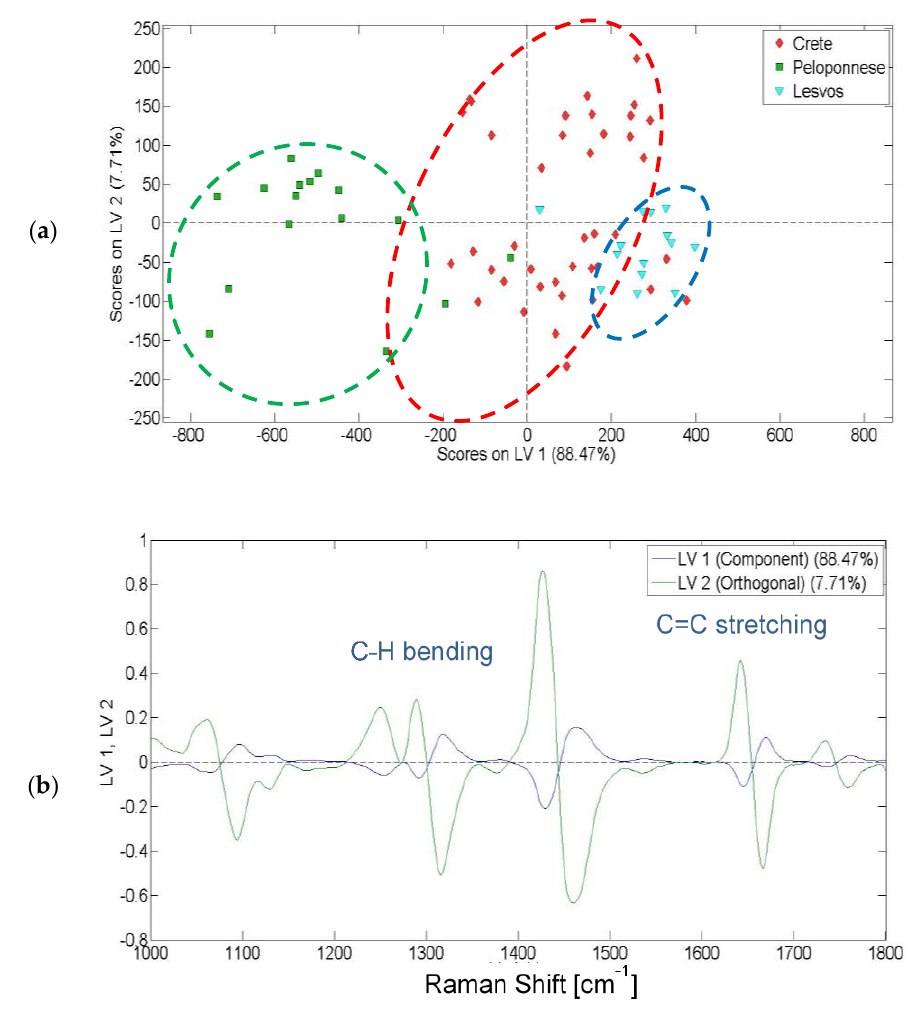
Figure 4. Classification of olive oils: ( a ) score plot for the discrimination of the olive oils from Crete, Peloponnese and Lesvos using Raman spectroscopy; ( b ) loading plot based on Raman spectra.